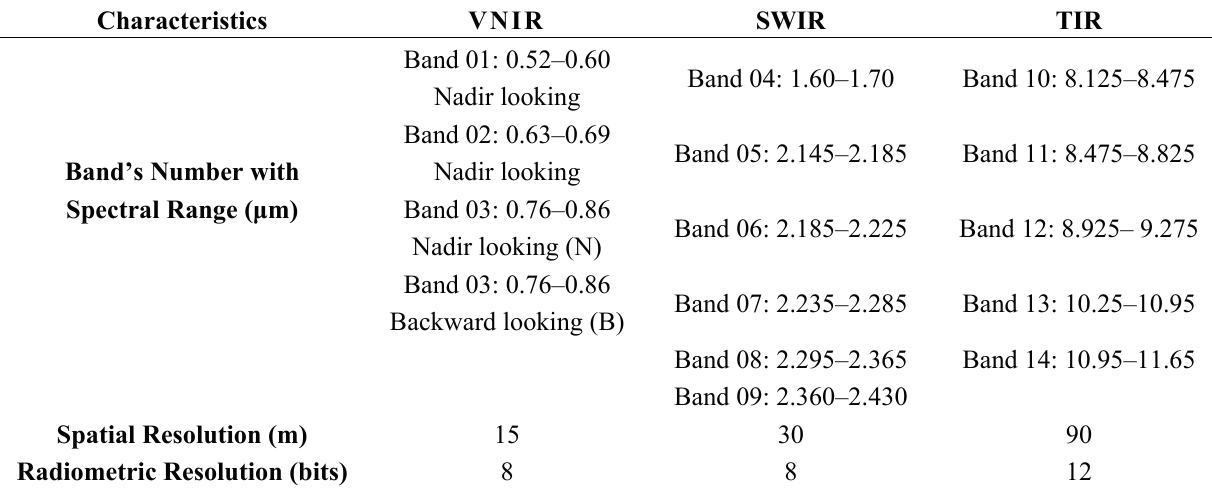
Table 1. ASTER sensor instruments